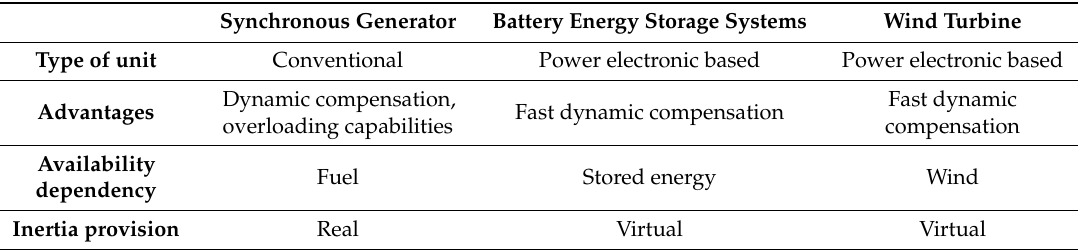
Table 2. Overview of methods to achieve black start in offshore wind farms.